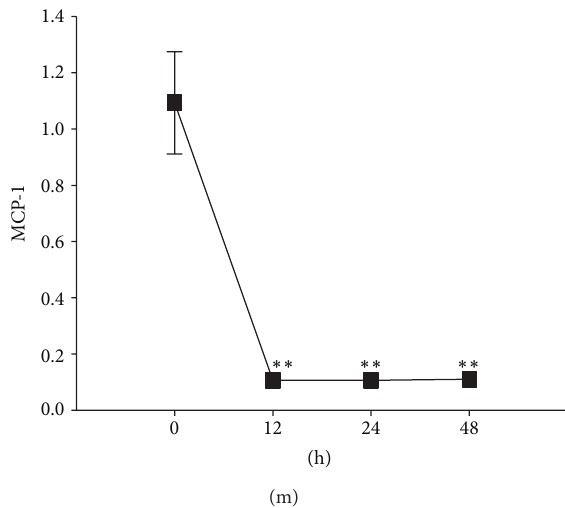
Figure 4: Seven migration related factors induced by supernatant of hypoxia CFs culture were upregulated in mRNA transcription level. VEGF (a), TNF- 𝛼 (b), MMP-9 (c), MMP-2 (d), SCF (e), TIMP-1 (f), EGF (g), SDF-1 (h), bFGF (i), G-CSF (j), HGF (k), HIF-1 𝛼 (l), and MCP-1 (m) mRNA transcription levels in supernatants of CFs under different period of hypoxia. mRNA levels of VEGF, TNF- 𝛼 , MMP-9, and MMP-2 mRNA peaked at 24 h, while mRNA levels of SCF, SDF-1, bFGF, G-CSF, HGF, HIF-1 𝛼 , and MCP-1 declined in a timely dependent manner with the period of hypoxia treatment. Lastly, mRNA levels of EGF and TIMP-1 showed no change with hypoxia treatment at all. Results are shown as the mean ± SD values. Experiments were repeated three times. ∗ indicates 𝑃 < 0.05 compared to the 0h group. ∗∗ indicates 𝑃 < 0.01 compared to the 0h group. # indicates 𝑃 < 0.05 compared to the 24 h group. ## indicates 𝑃 < 0.01 compared to the 24 h